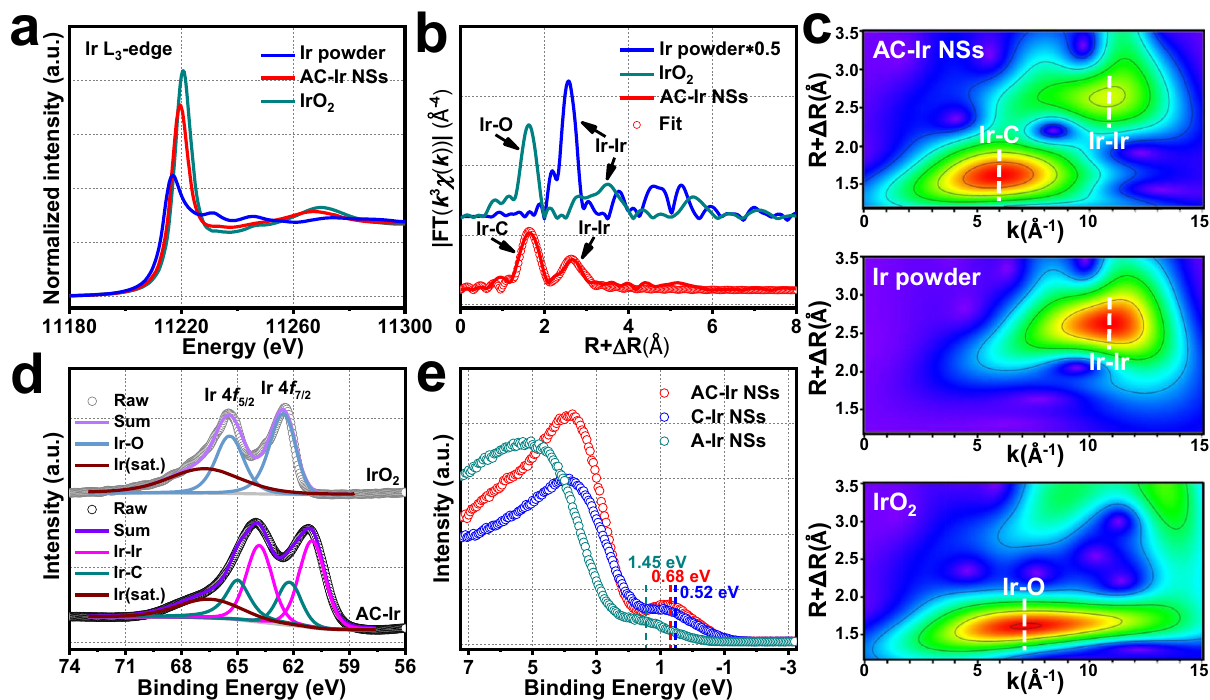
Fig. 4 Electronic structure and coordination information of AC-Ir NSs. a XANES spectrum, ( b ) Fourier transformed of k 3 -weighted χ (k)-function of the EXAFS spectrum and ( c ) The wavelet transform spectra of AC-Ir NSs, Ir powder and commercial IrO 2 , respectively. d Ir 4 f XPS spectrum of AC-Ir NSs